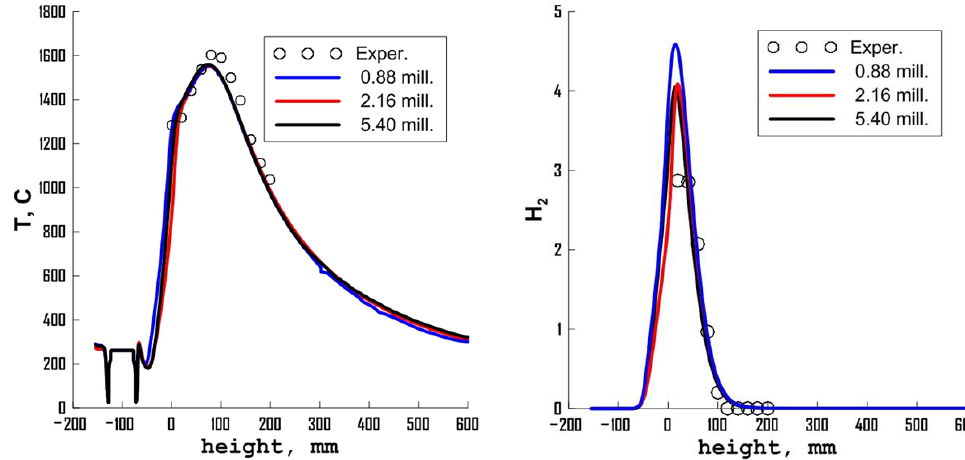
Figure 4. Comparison of the calculation results obtained for different grid sizes.